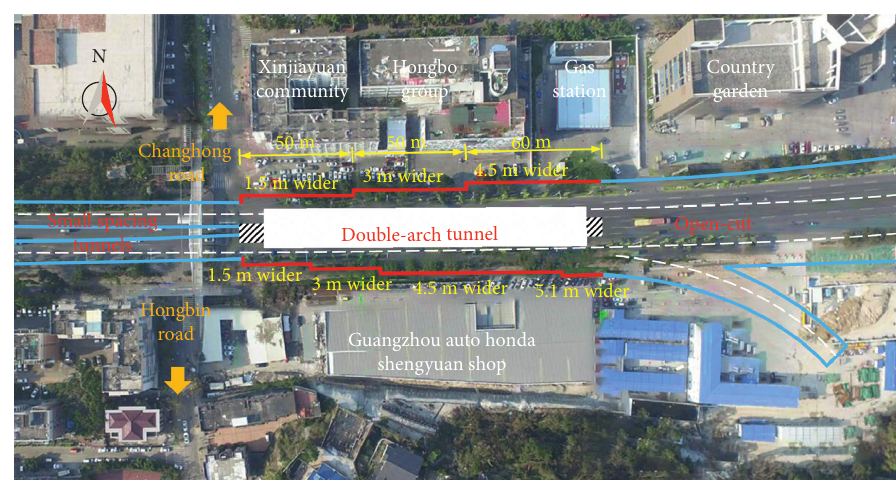
Figure 2: Plan view of double-arch tunnels.